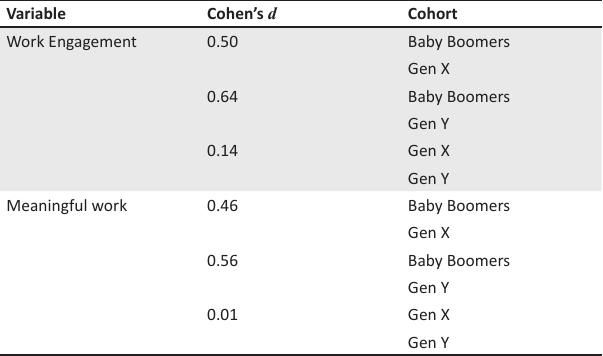
TABLE 7: Effect size (Cohen’s d ) for differences between groups for engagement and meaningful work. Variable Cohen’s